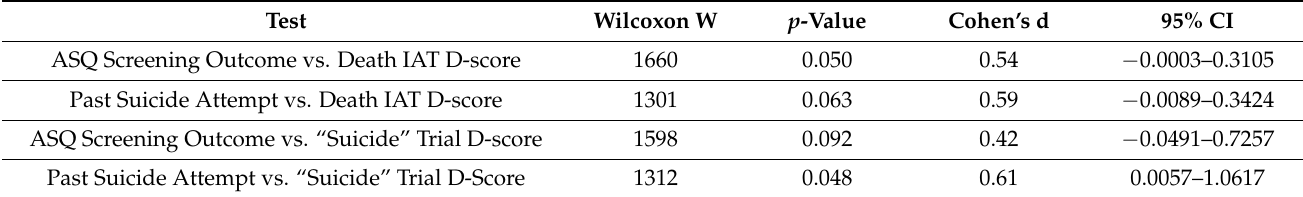
Table 3. Wilcoxon Rank Sum Tests to compare D-Scores and ASQ Responses ( n = 176).